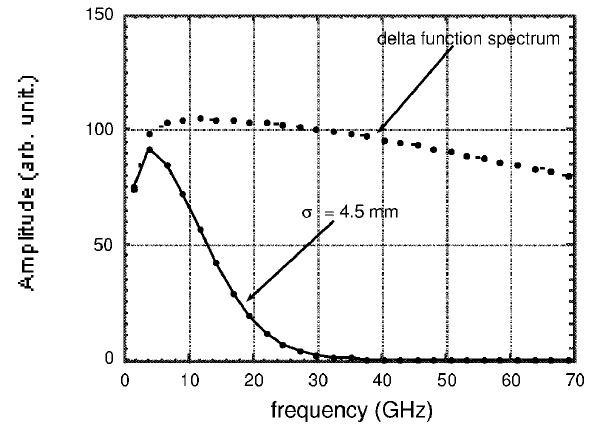
FIG. 10. Amplitude spectrum excited by a Gaussian beam with 1 s (cid:1) 4.5 mm (solid line) compared with the delta function am- plitude spectrum (dashed